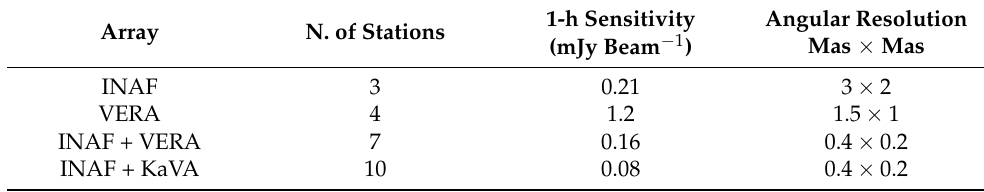
Table 1. List of VLBI arrays and their performances at 22